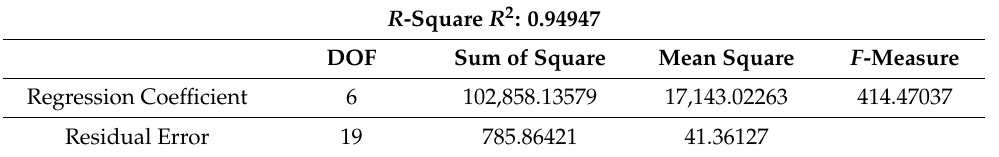
Table 6. Significance analysis of model